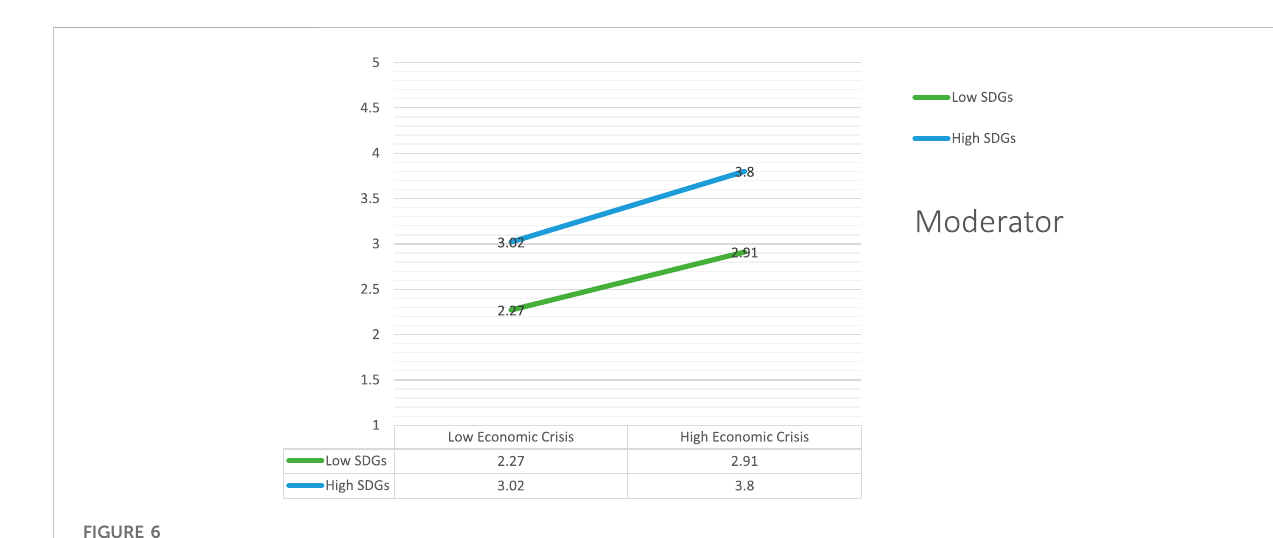
FIGURE 6 Moderating effect 1.